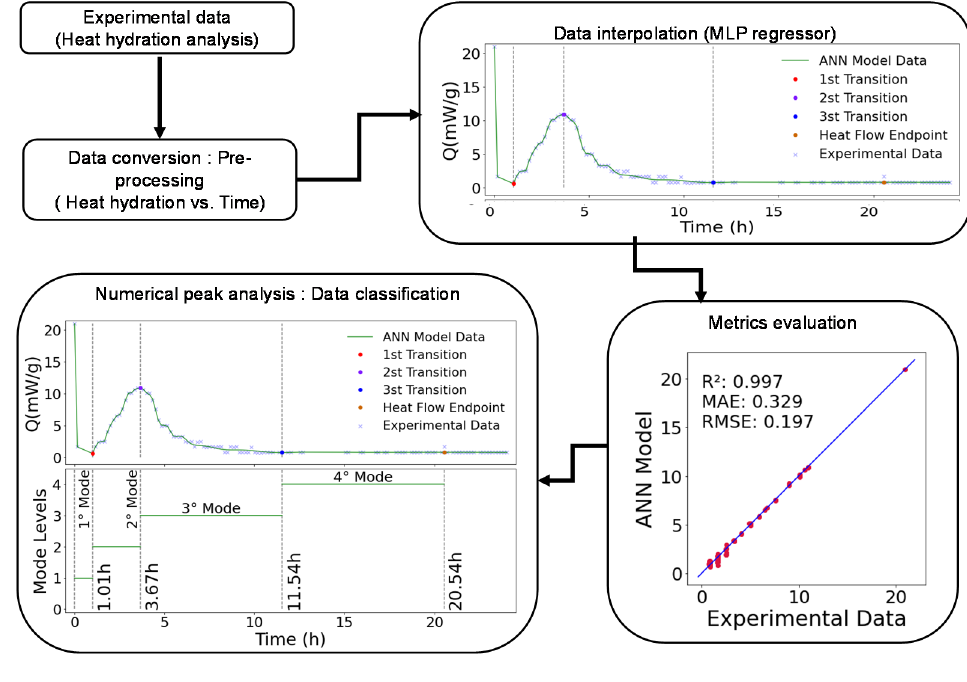
Figure 5. Computational procedure for hydration process classification proposed model.